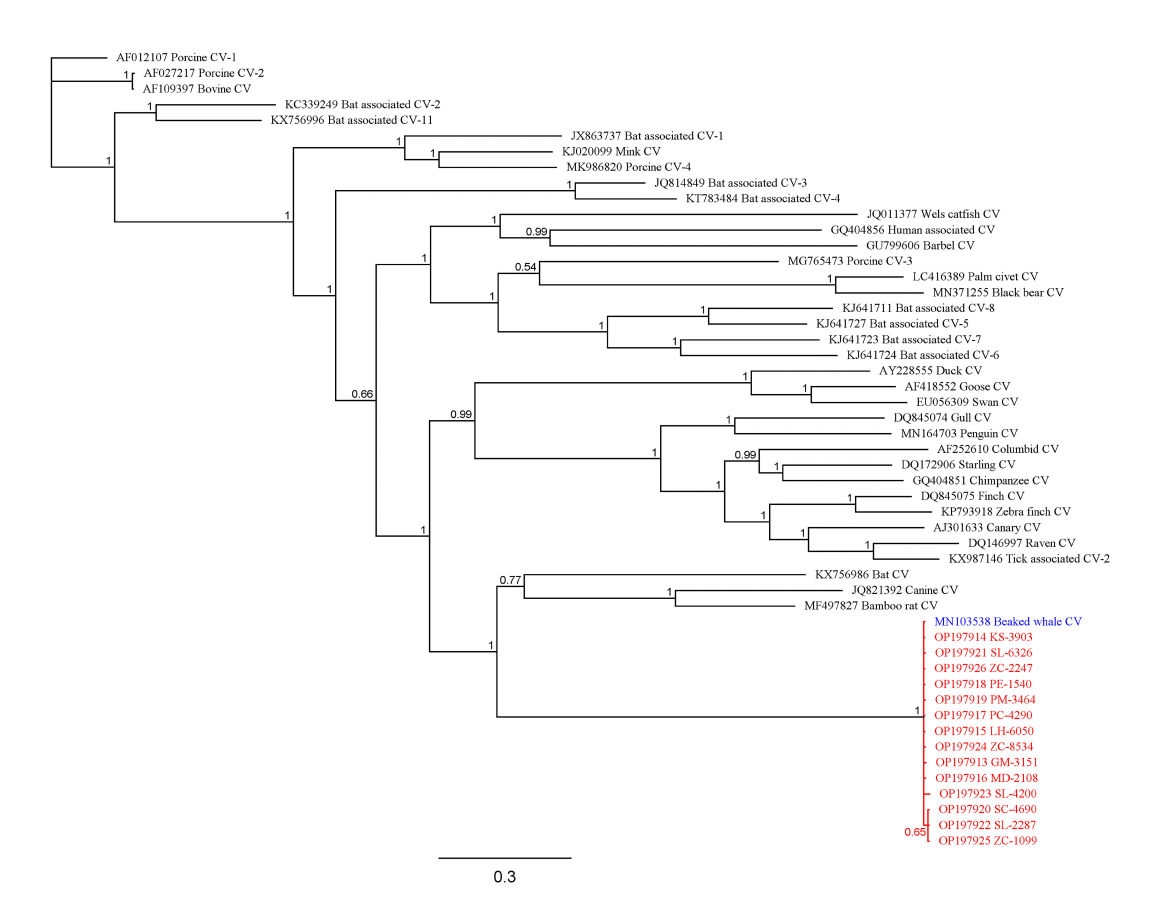
FIGURE 2 Bayesian phylogenetic tree showing relationships between study sequences (red), BWCV reference genome (blue), and other circoviruses (black). Posterior probabilities are denoted at branching